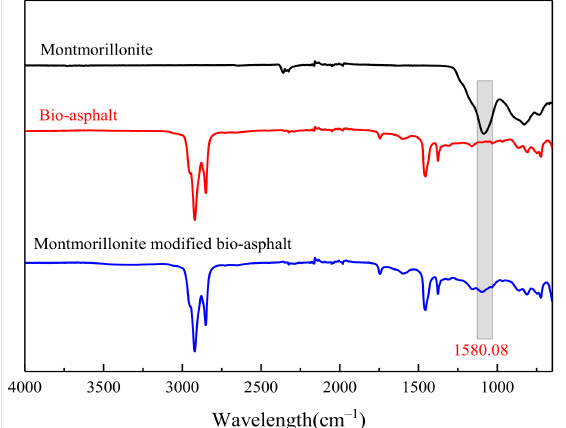
Figure 19. Infrared spectroscopy of montmorillonite, bio-asphalt and montmorillonite- modified